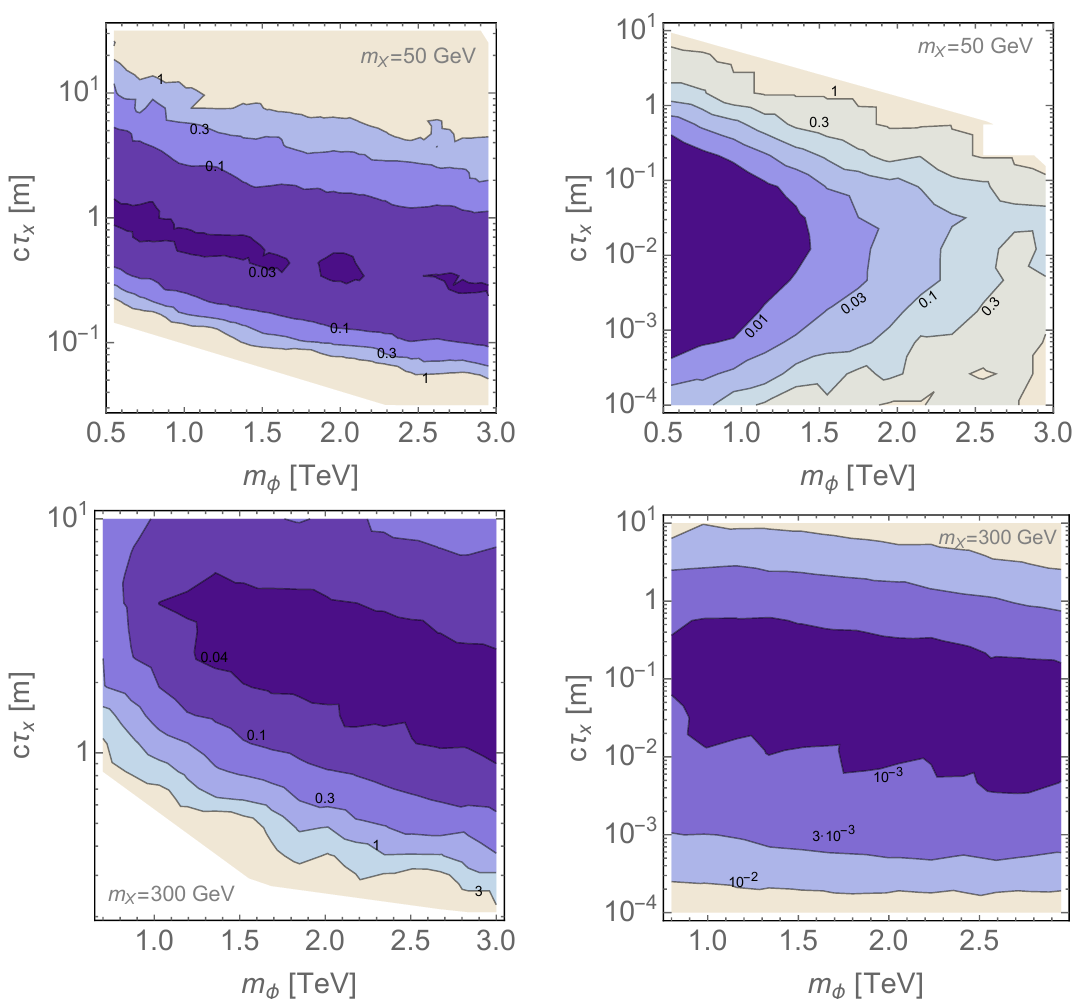
Figure 7 . Contours of the excluded signal strength (cid:27) (cid:30) (cid:1) BR in the ( m (cid:30) , c(cid:28) X ) plane for the two LLP searches discussed in the text: Left: ATLAS (cid:22) -RoI search at 8 TeV [41] Right: CMS IT search at 8 TeV [35]. The upper/lower panels refer to m X = 50 GeV/ m X = 300 GeV,